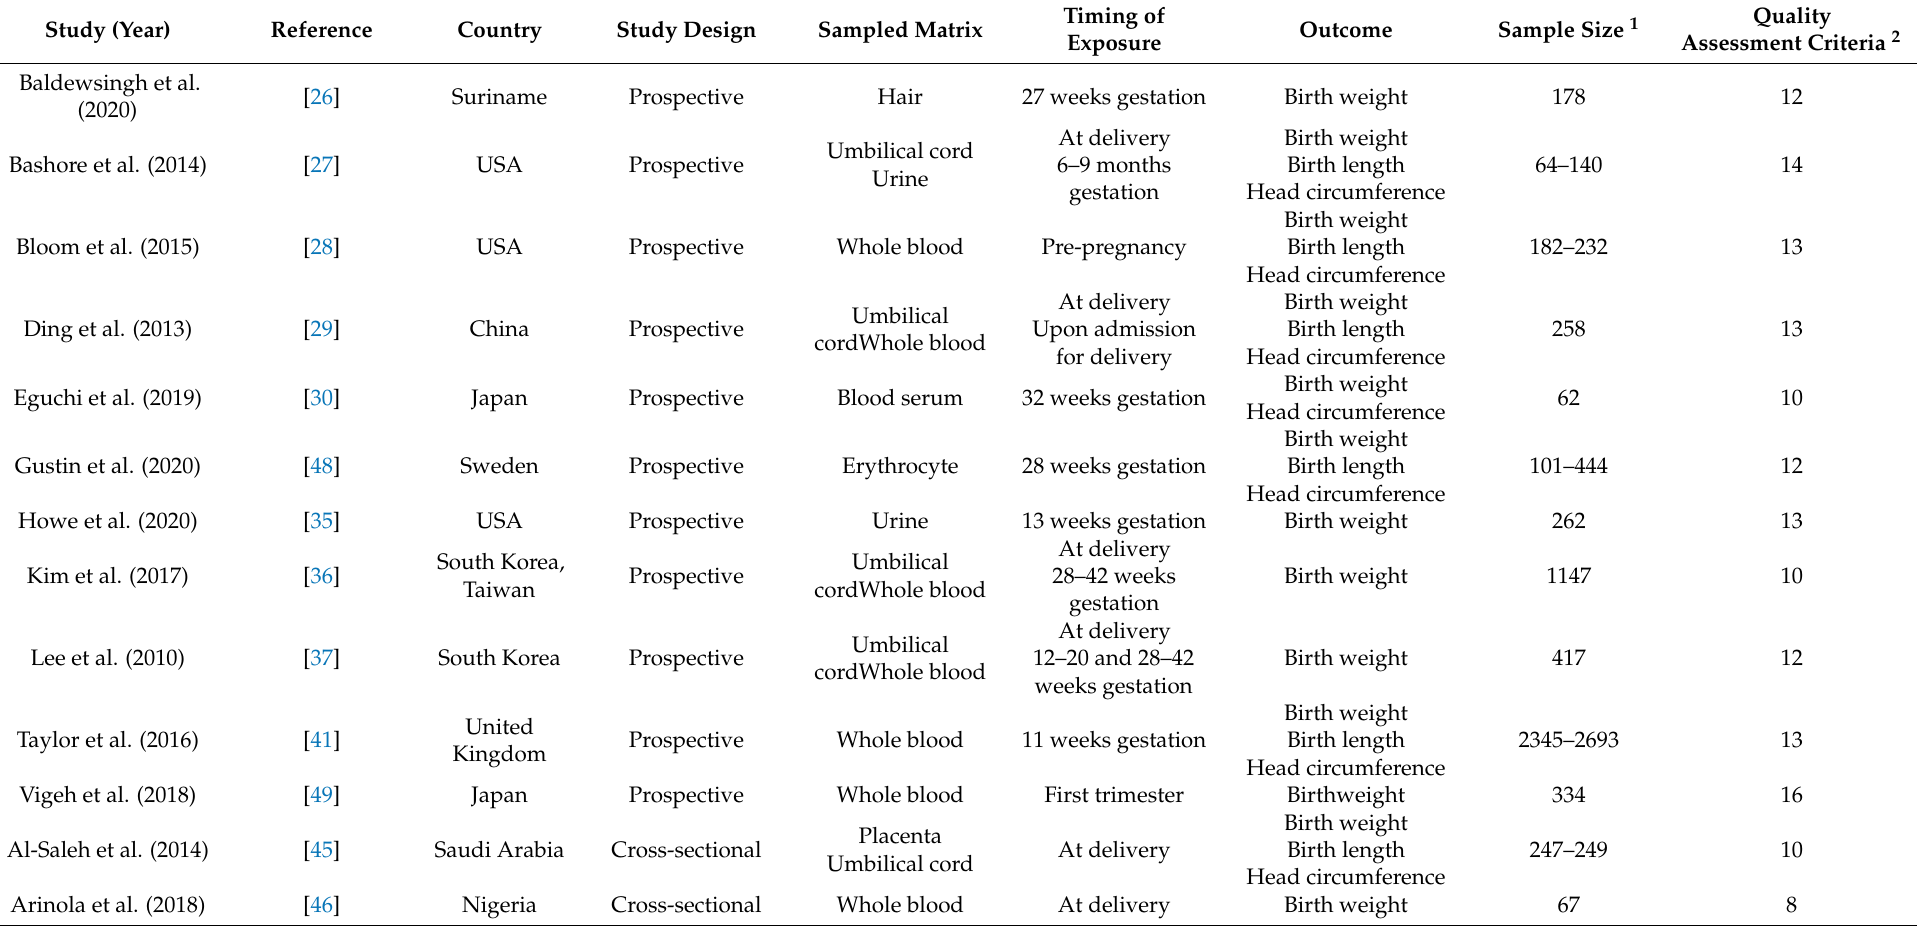
Table A1. Characteristics of included